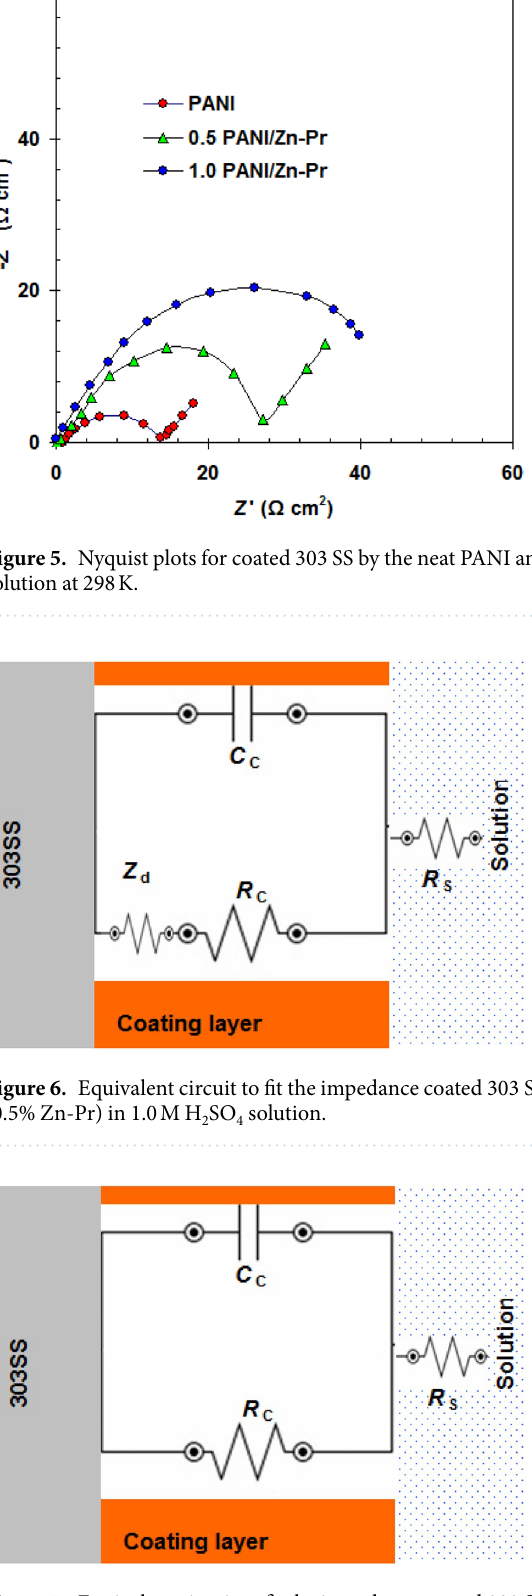
Figure 7. Equivalent circuit to fit the impedance coated 303 SS by PANI/Zn-Pr composite (1.0% Zn-Pr) in 1.0 M H 2 SO 4